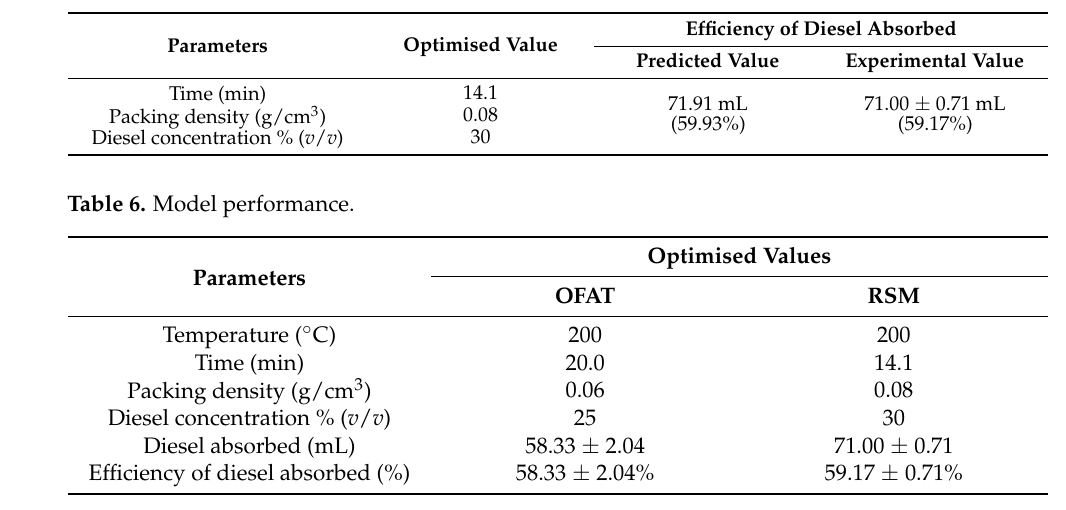
Table 5. RSM model validation using the optimal predicted values.